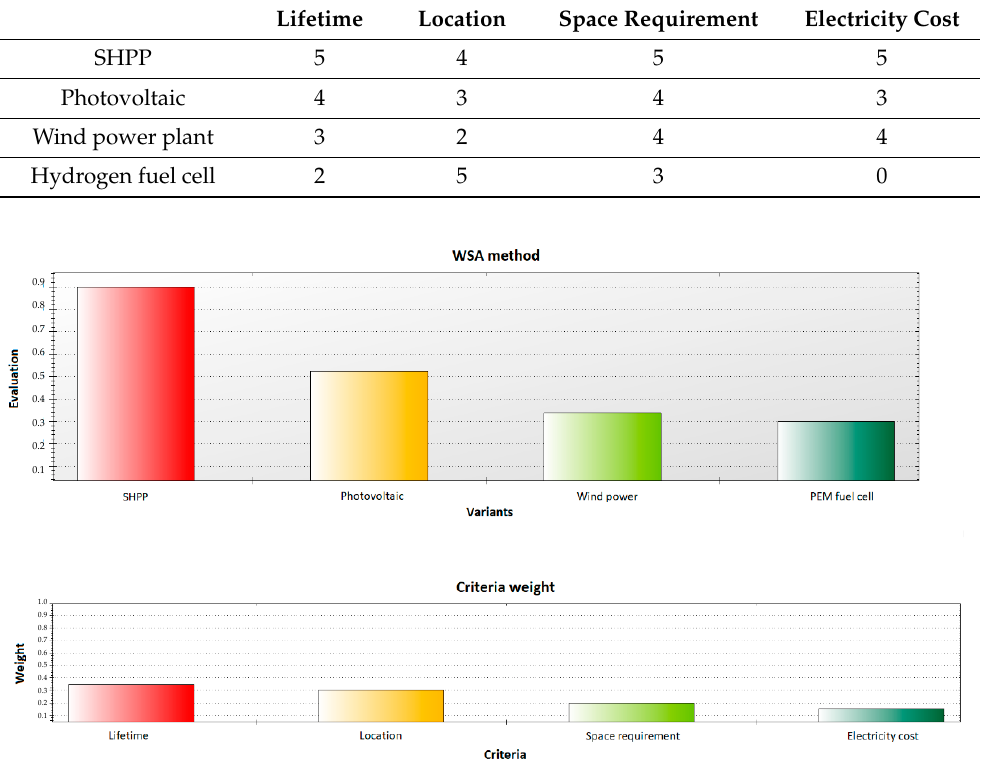
Table 5. Strengths and weaknesses of the renewable power courses.